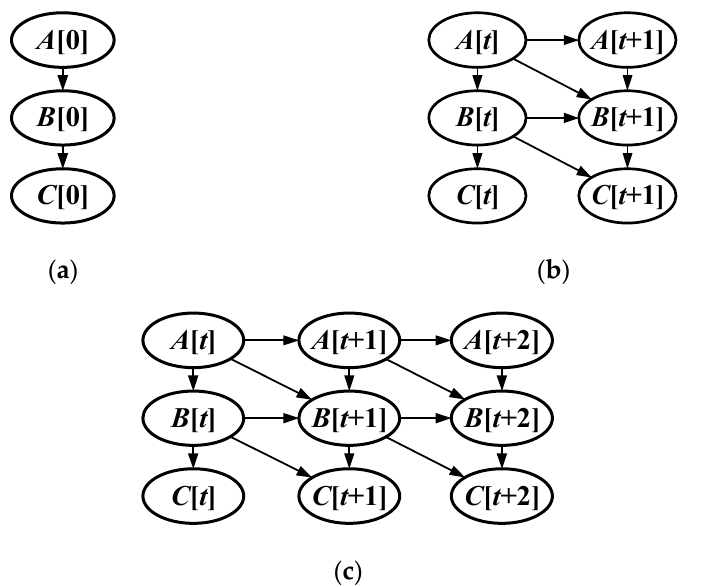
Figure 4. The DBN. ( a ) Prior network, ( b ) Transfer network, ( c ) DBN inference.